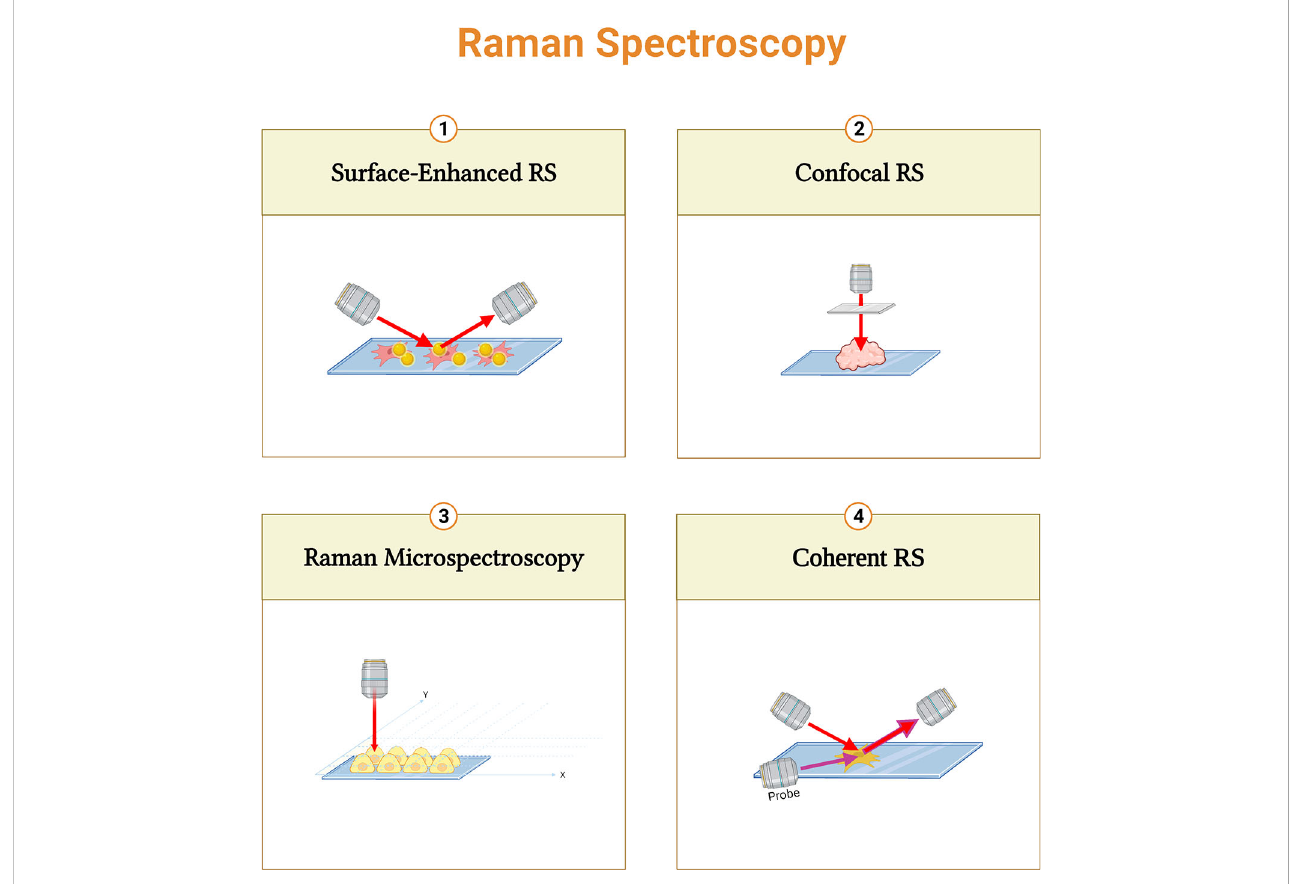
FIGURE 3 Summary of different Raman spectroscopy techniques. Surface-enhanced RS (SERS) performs enhanced signals with metal nanoparticles; Confocal RS is a combination of confocal microscope and RS; Raman micro-spectroscopy combines RS with microscope; and Coherent RS is RS with two light